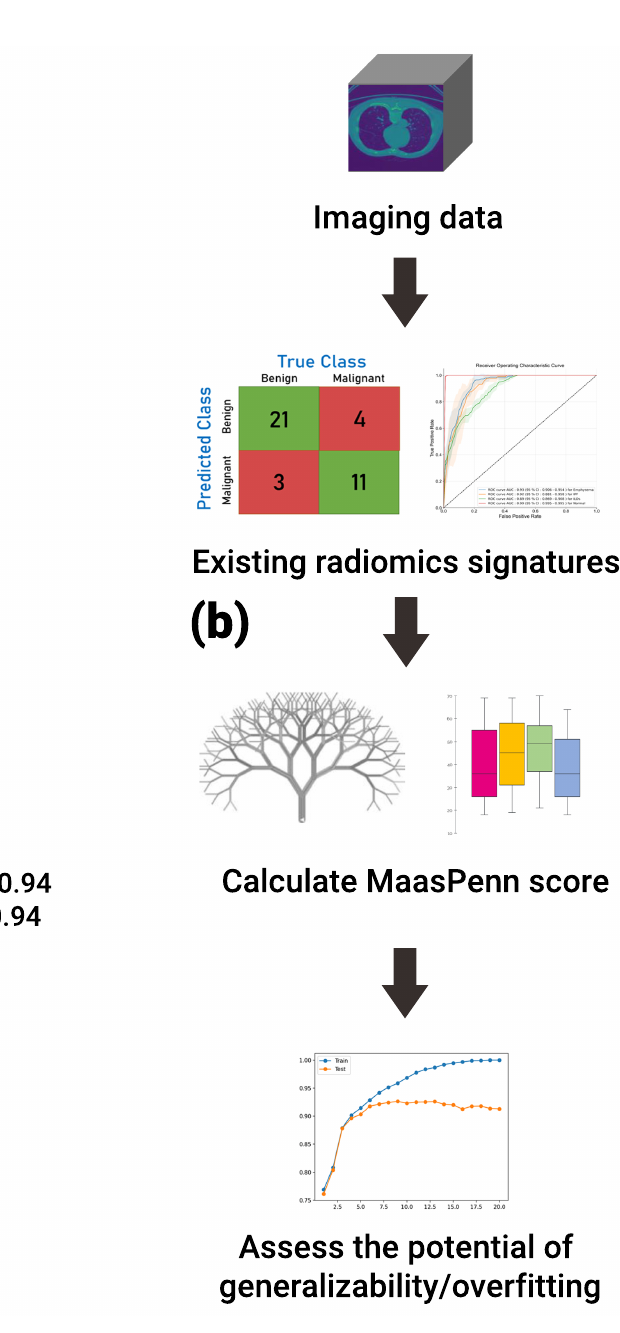
Figure 5. The proposed workflow of MaasPenn score for ( a ) planning new analyses; and ( b ) evaluat- ing previously developed